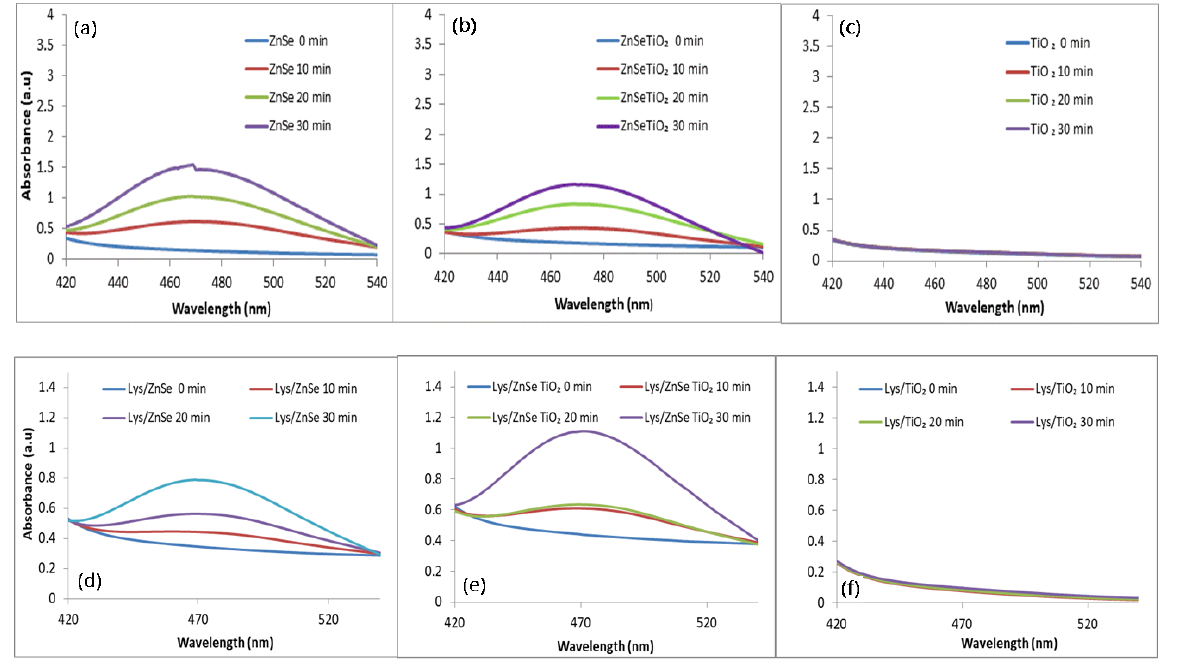
Figure 18. The time course of O 2• − formation over inorganic ( a – c ) and lysozyme modified samples ( d – f ) under visible light irradiation.